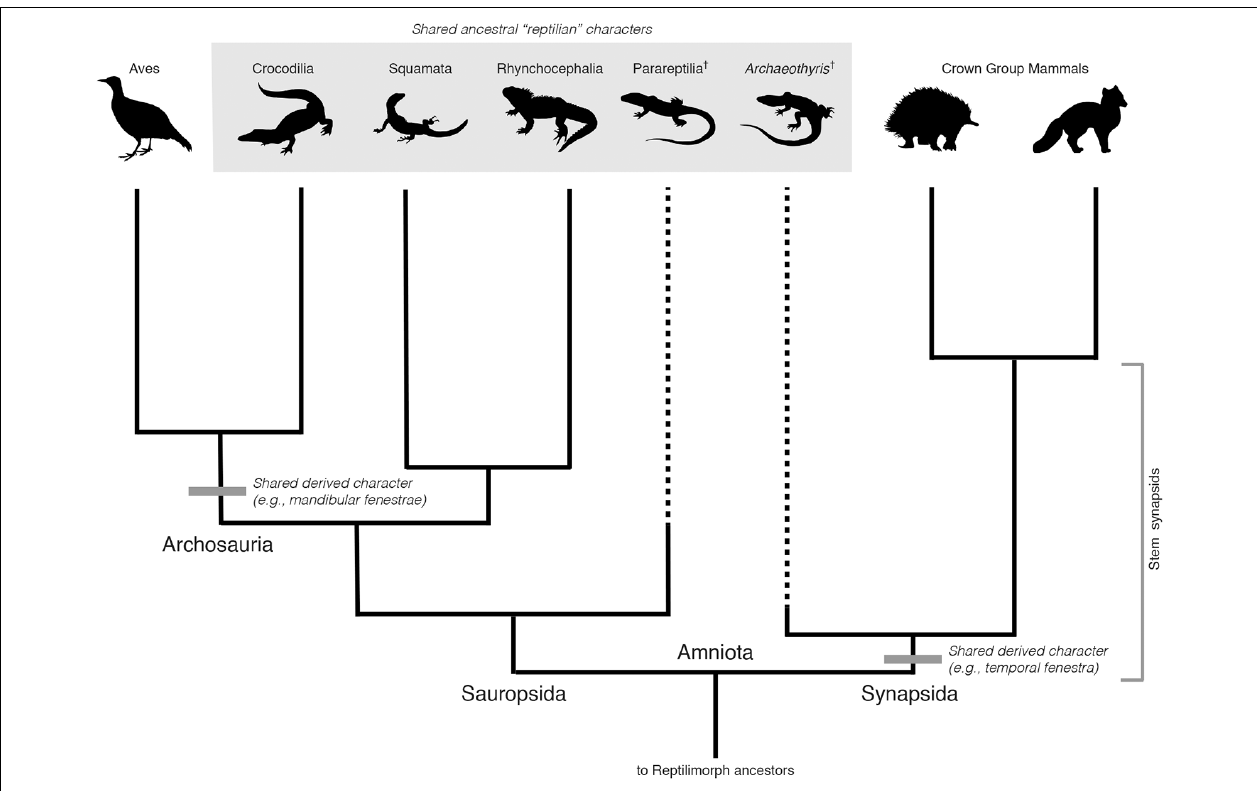
FIGURE 1 | Phylogeny of selected major groups of amniotes. Selected synapomorphies are indicated by gray bars. Two basal extinct lineages Parareptilia and Archaeothyris (representing Ophiacodontidae) are included to indicate the retention of shared ancestral characters (large gray box). Sauropsida includes all extant reptiles and their extinct relatives. Extant anapsids (turtles) are omitted due to their uncertain placement within Sauropsida. Synapsida and Sauropsida are clades of equal taxonomic rank, with a last common ancestor congruent with the ancestor of all crown group amniotes (Amniota). Archosauria is a clade nested within Sauropsida. As such, it has a lower taxonomic rank than either Sauropsida or Synapsida, even if shared derived characters of this group distinguish them from other amniotes. Representative taxon images were downloaded from PhyloPic (http://phylopic.org/). All images are uncopyrighted except parareptilia (http://phylopic.org/image/00b96cf3-1802-4bda-a6cc-76aea0f6f05e/) which is owned by Nobu Tamura (vectorized by T. Michael Keesey), under the following creative commons license